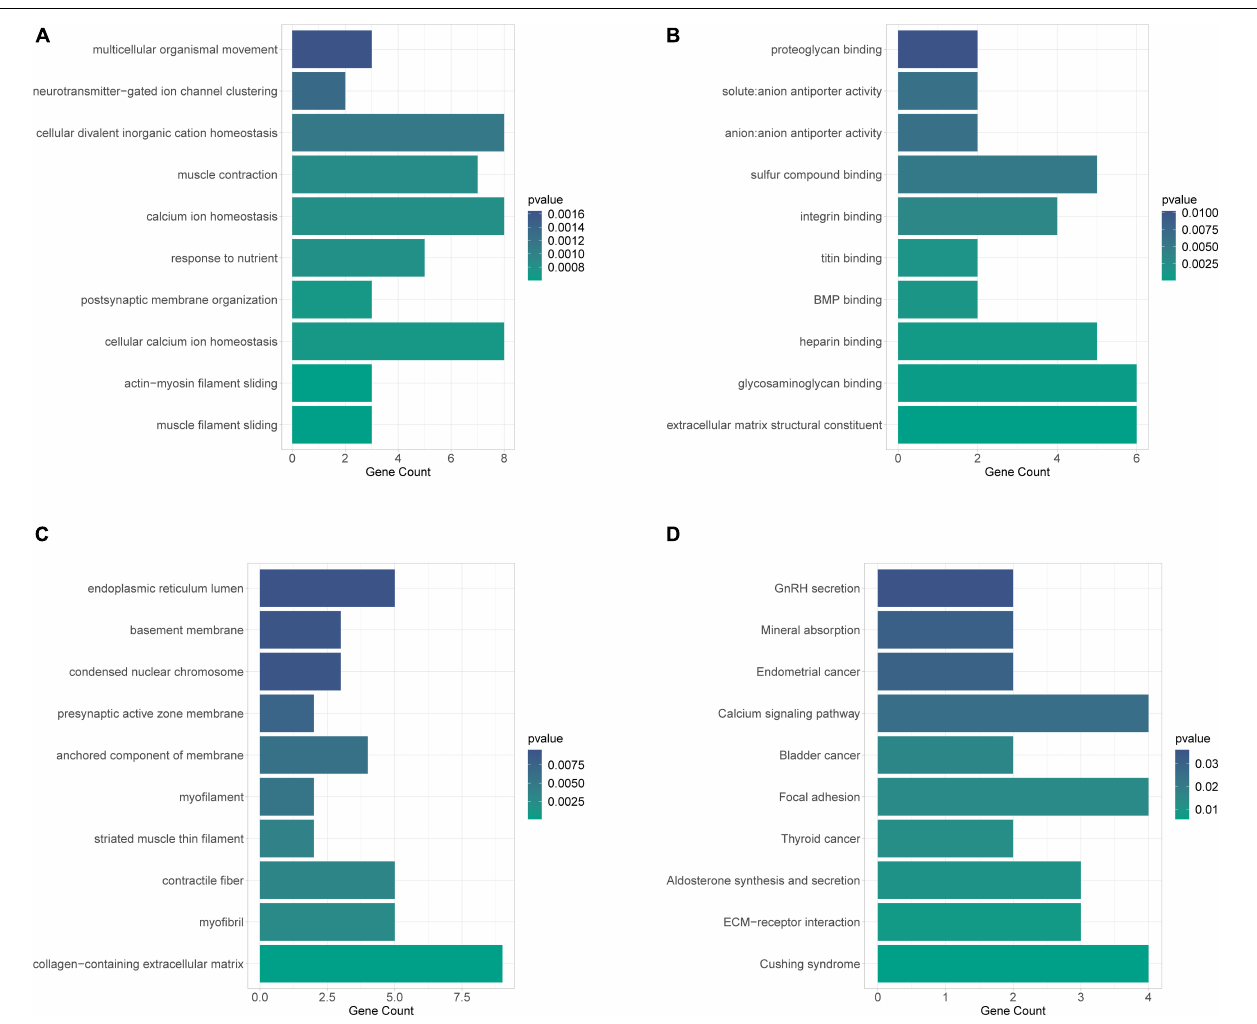
FIGURE 4 | GO annotation and KEGG pathway analyses to obtain a primary understanding of the biological functions and pathways of target mRNA. (A) Bubble plot of BP; (B) bubble plot of MF; (C) bubble plot of CC; (D) top 10 enrichment of KEGG pathway analysis of DEGs.